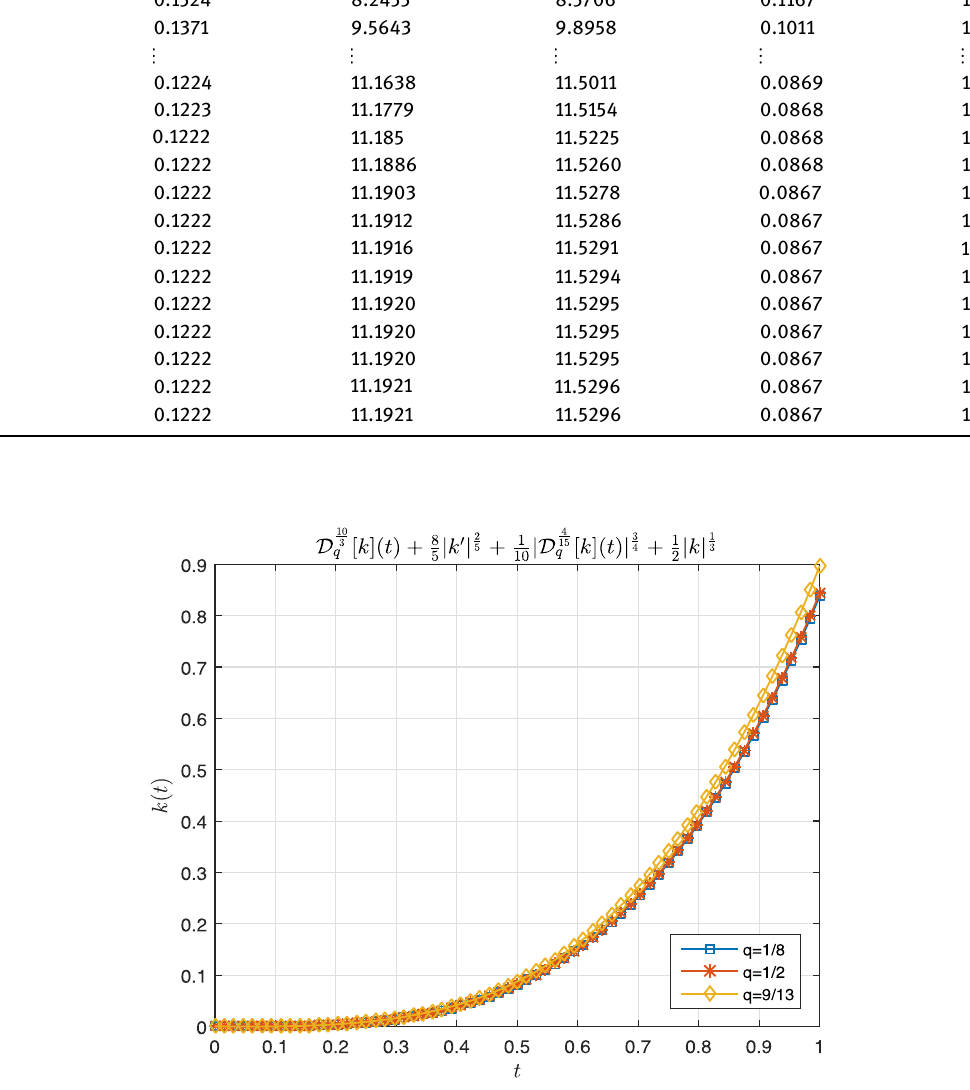
1 9 , respectively, according to Table 8 2 13